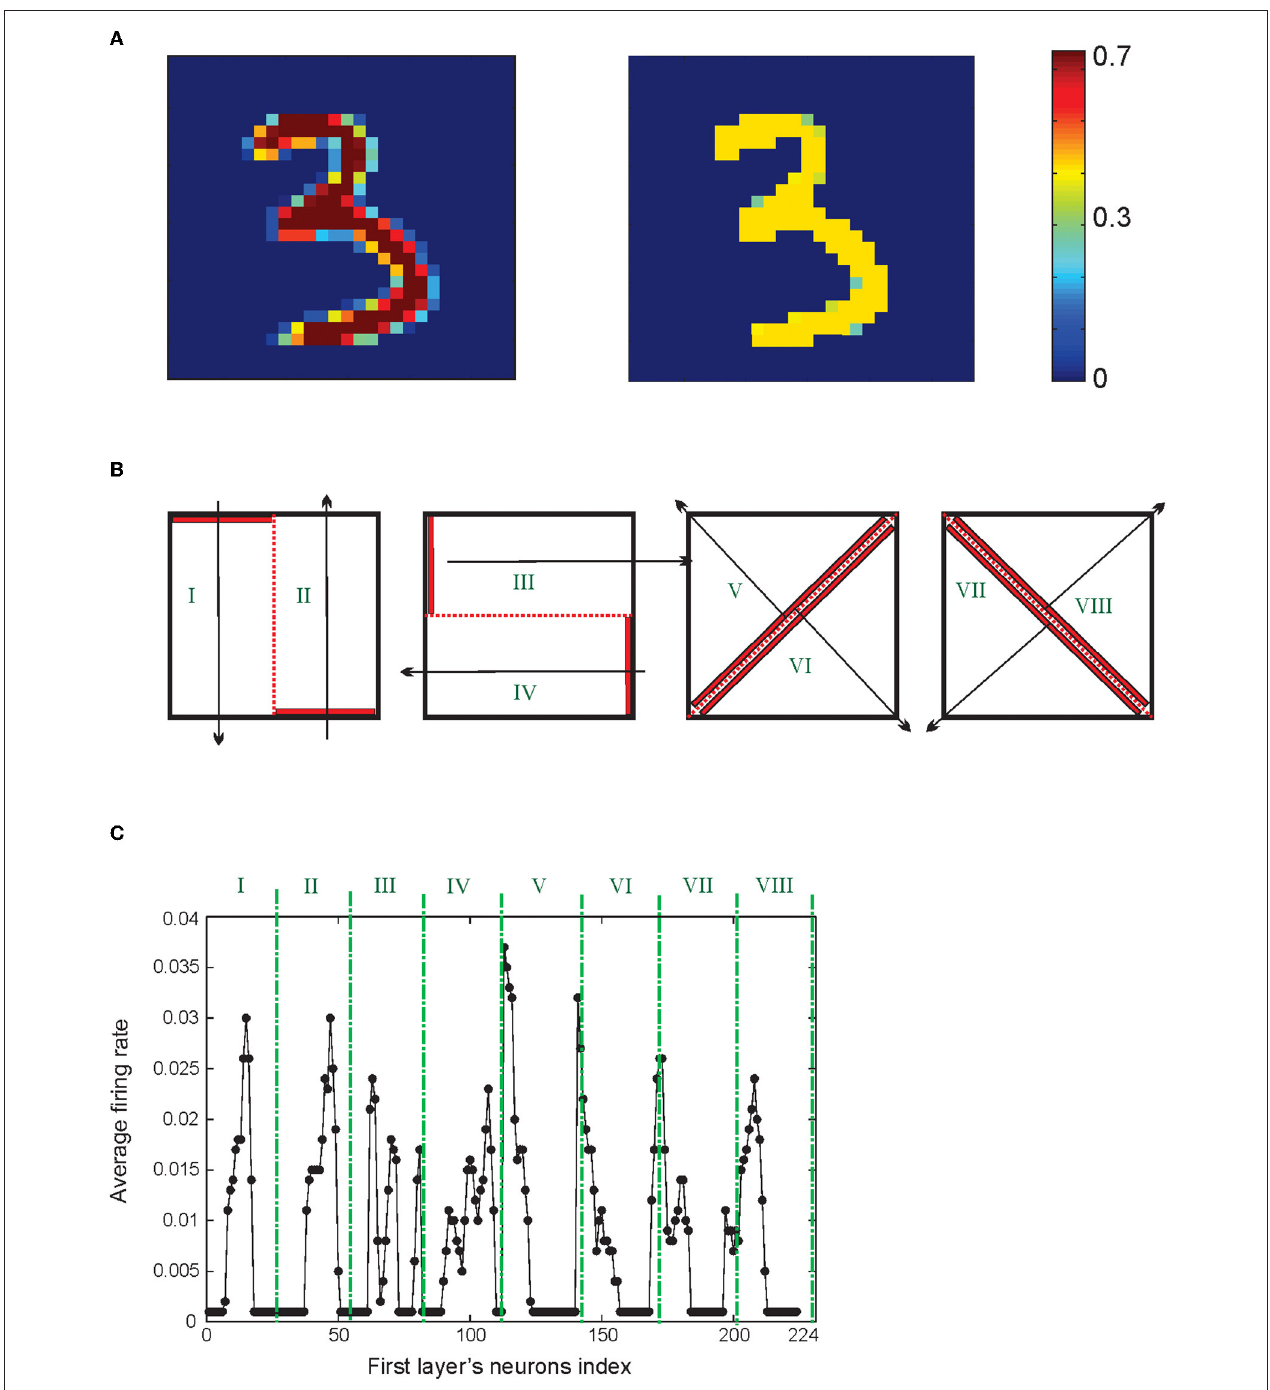
FIGURE 3 | (A) Image preprocessing. A hand-written image is used as a matrix of pixel values ranging from 0 to 255 that is normalized between 0 and 0.4. (B) Representation of the information of the image as the neuronal activity of neurons in the first layer. For this purpose, matrices of pixels are divided into eight regions. The neuronal activity of 28 neurons of each region is shown in (C) .